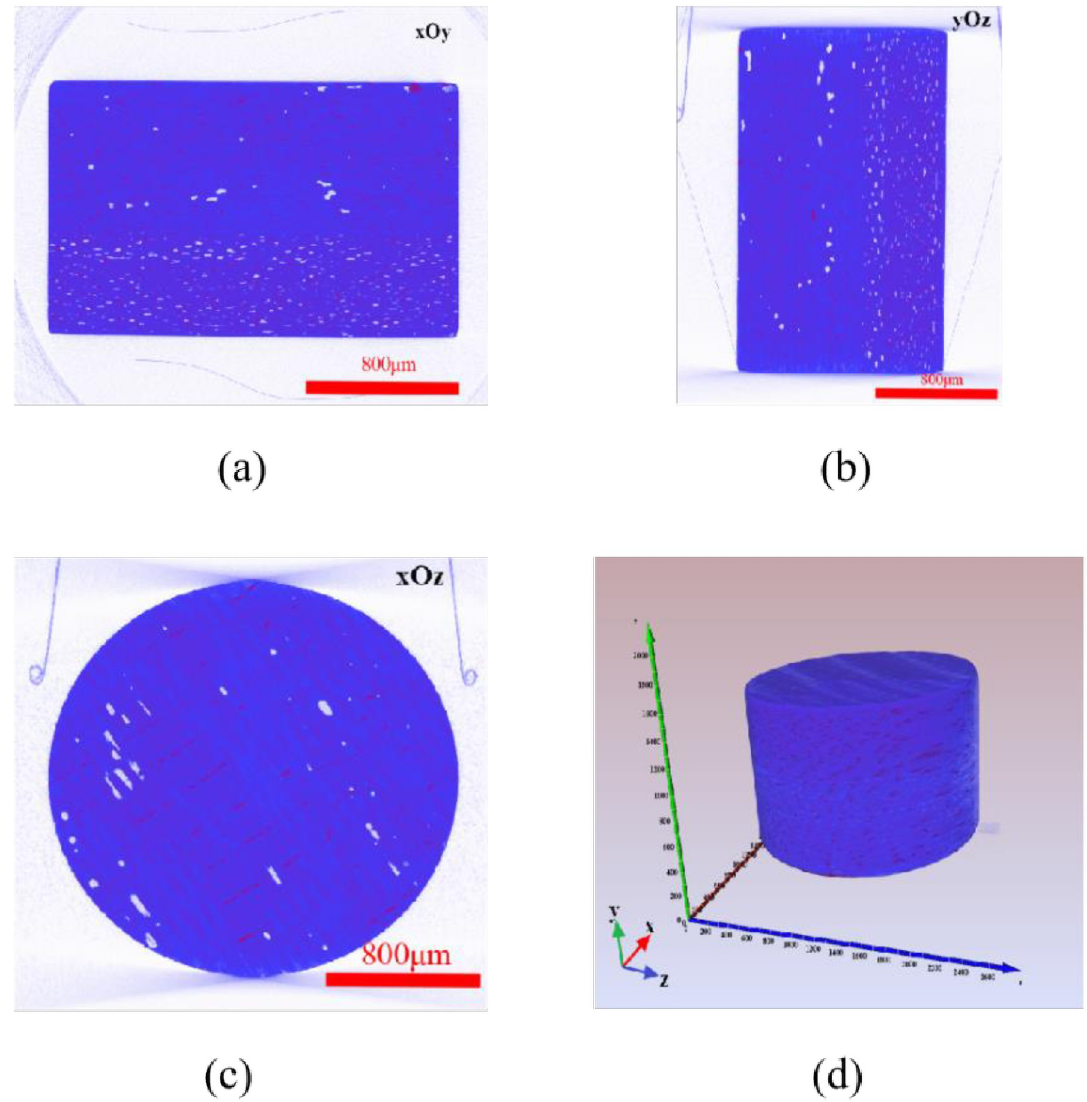
Fig 1. Scanning slices and three-dimensional data in X, Y and Z directions: (a), (b) and (c) are scanned slices in the direction of xOy, yOz and xOz respectively, and (d) are three-dimensional data.